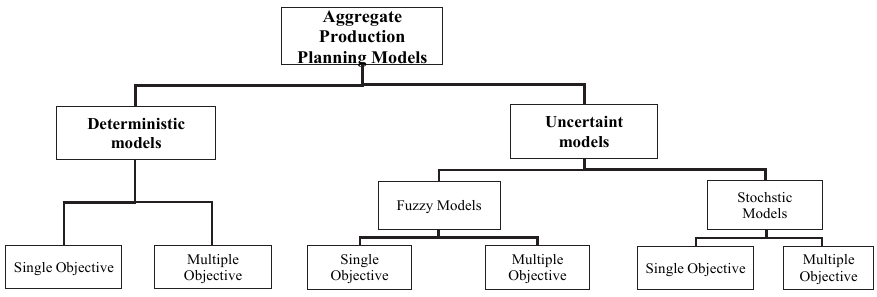
Fig. 1. Structural groups for APP